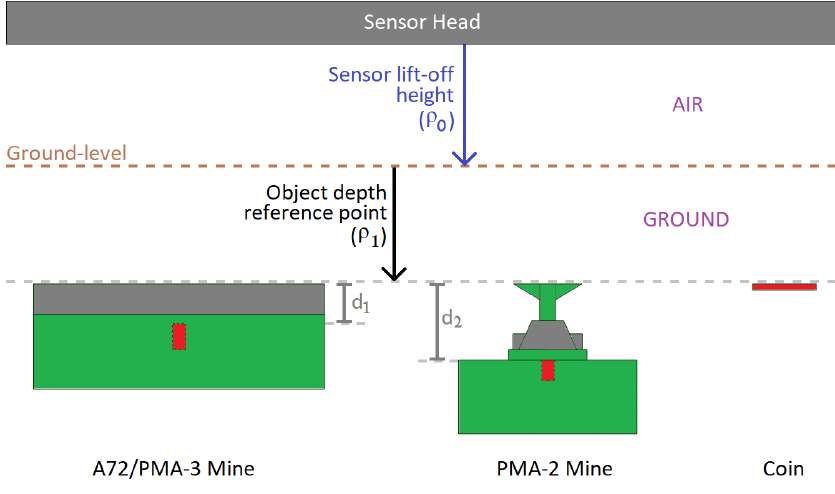
Figure 10. Description of object depth measurements and orientation with metallic components